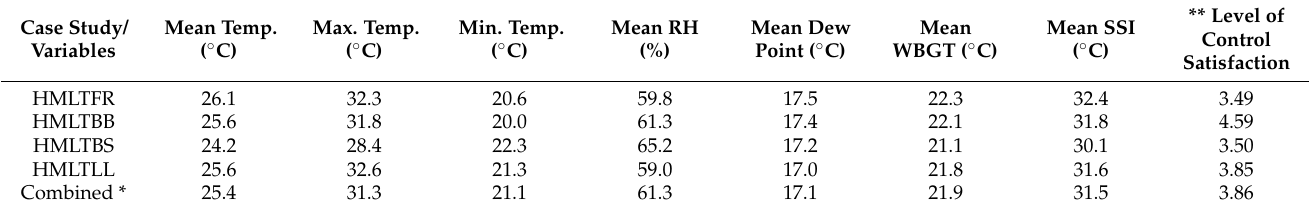
Table 7. Summary of the adaptive approaches for ASHRAE-55 and EN 16798-1 comfort